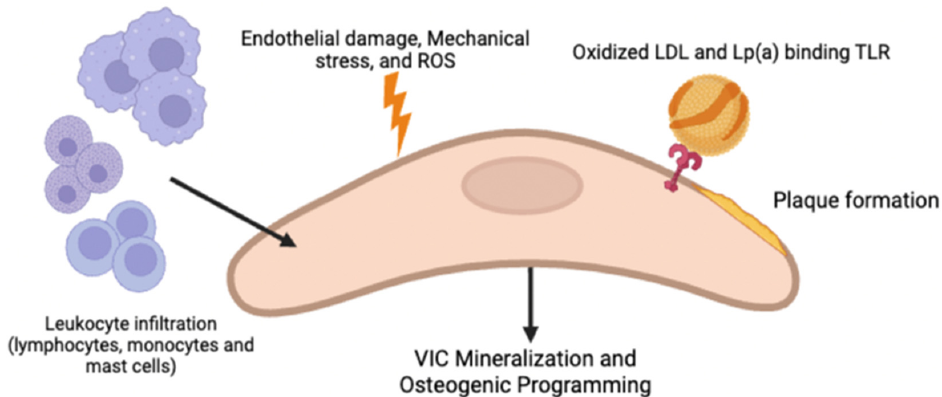
Figure 1. Pathogenesis of CAVD involves lesions from endothelial damage, mechanical stress, and ROS. This allows for oxidized LDL and Lp(a) infiltration, plaque formation, and subsequent leukocytic infiltration of VICs. This leads to progressive mineralization and osteogenic programming of VICs [4,6].